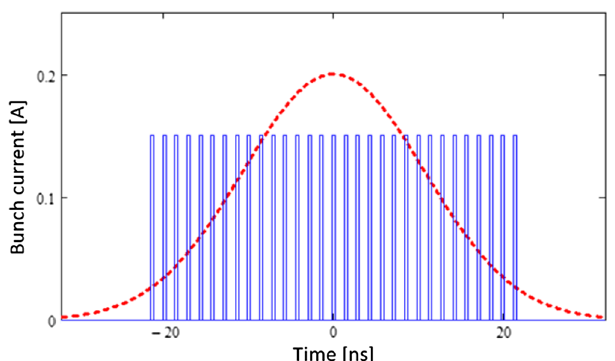
FIG. 6. Longitudinal distribution of the ion bunch (dashed red line) overlapped with the electron macrobunch (solid blue line) containing 30 bunches.